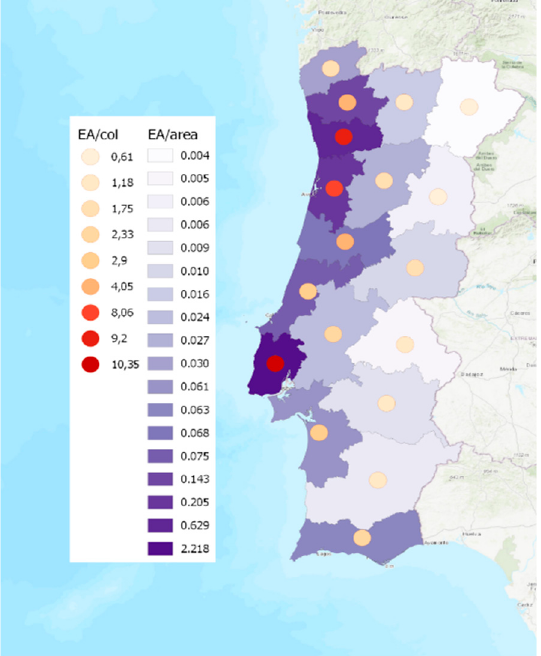
Figure 13. EAM identifies the levels of propensity in the use of new technology vehicles, which are considered constraining factors, such as the limited number of recharging infrastructures (map elaborated with QGIS).